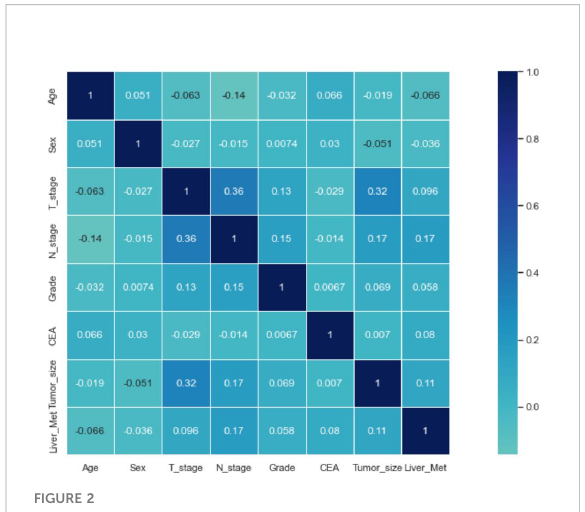
FIGURE 2 Results of the correlation heatmap between all variables. The graph shows the correlations between all variables.